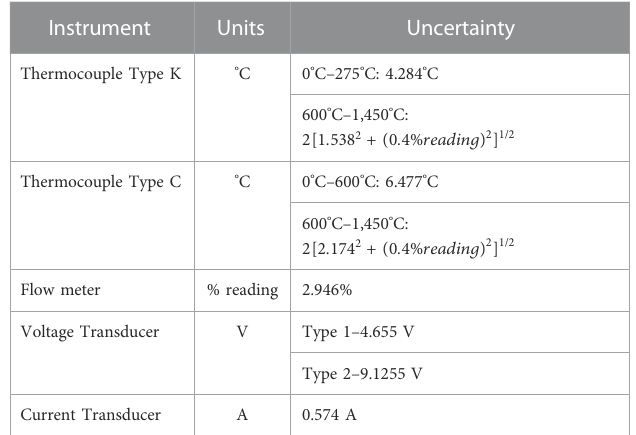
TABLE 5 HTTF Instruments